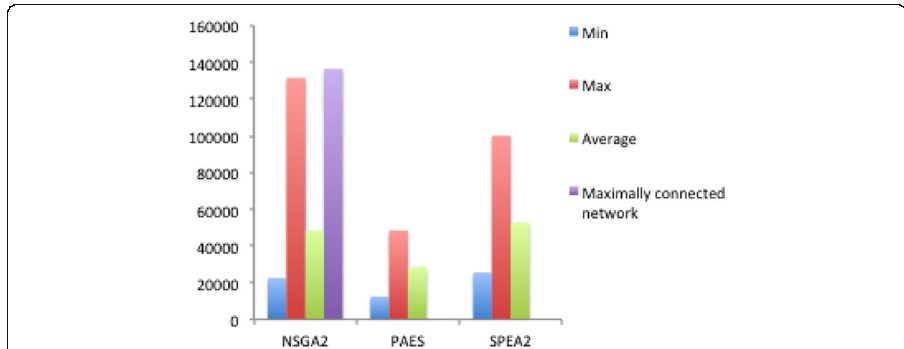
Fig. 7 Comparison of Minimum, Maximum and Average Costs obtained by each algorithm to a fully connected